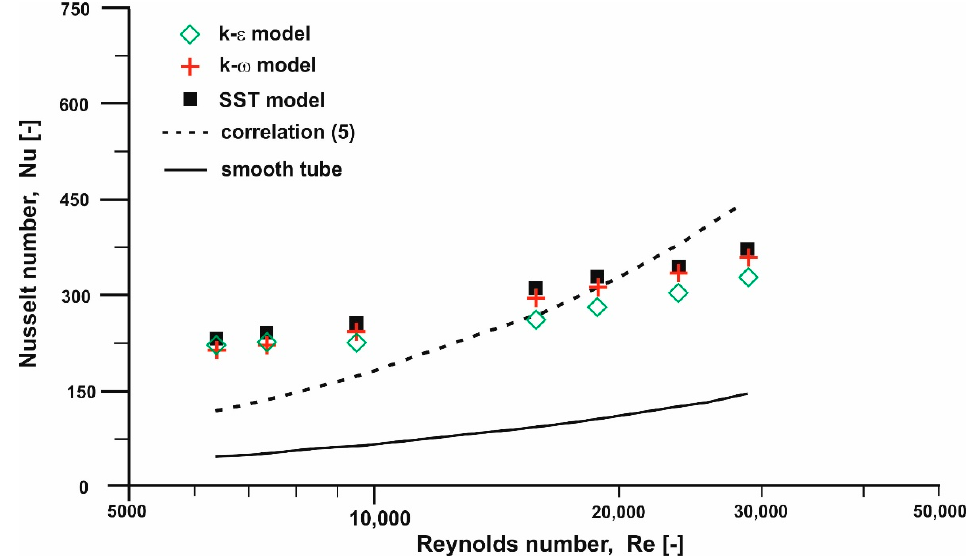
Figure 7. Comparison between Nusselt number values obtained from CFD modelling and correlation (5) for a tube with internal spiral ribs and for a smooth tube (heater power—6 kW).